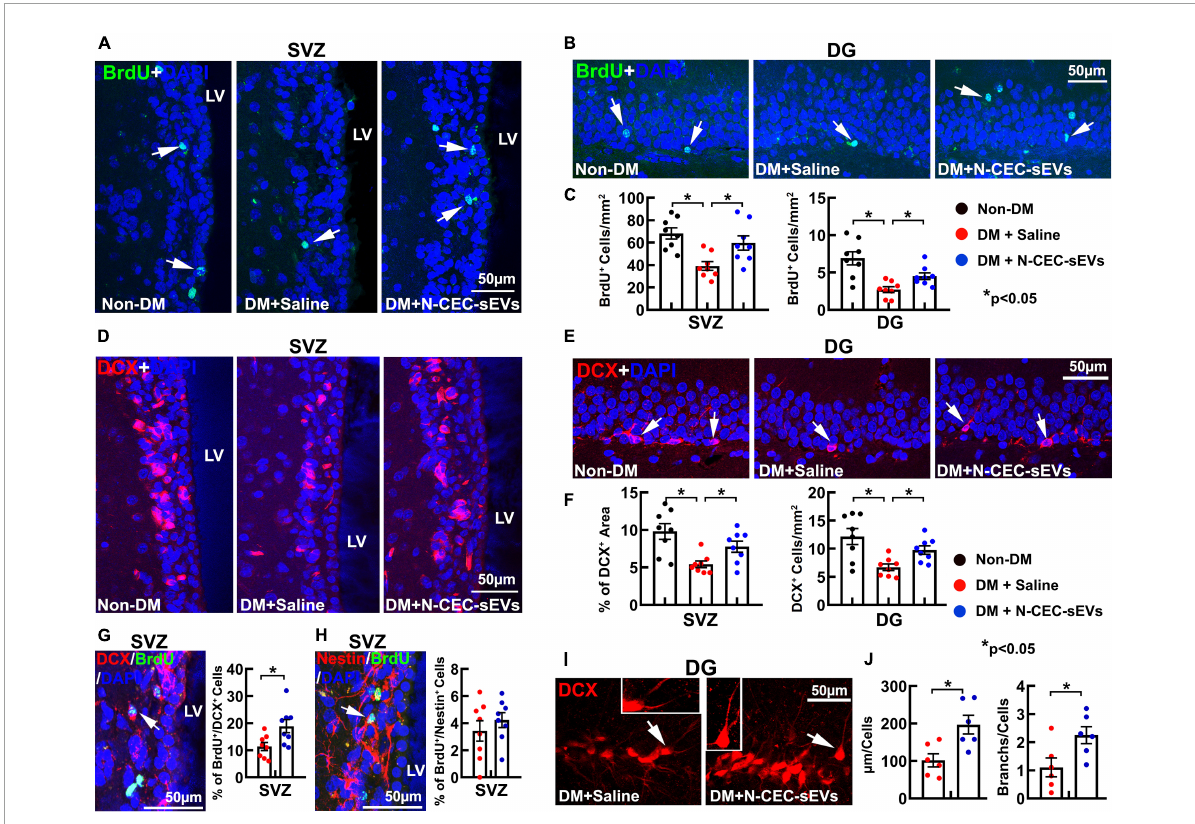
FIGURE3 N-CEC-sEV treatment promotes neurogenesis. Representative microscopic images (A,B) and quantitative data (C) of the BrdU positive cells (green, arrow) in the SVZ (A) and the DG (B) of age-matched non-DM rats and aged-DM rats treated with saline and N-CEC-sEVs. Representative microscopic images (D,E) and quantitative data (F) show DCX + neuroblasts (red) in the SVZ (D) and the DG (E) . Representative microscopic images of BrdU + cells double labeled with DCX ( G , arrow) and Nestin cells ( H , arrow) in the SVZ of aged-DM rats treated with N-CEC-sEVs. Bar graphs in (G,H) are the quantitative data of BrdU + /DCX + and BrdU + /Nestin + double labeled cells in the SVZ of aged-DM treated with saline and N-CEC-sEVs. Representative confocal microscopic images of DCX + neuroblasts (red) in the DG (I) of aged-DM rats. Inserts in I show a DCX + neuroblast (arrow in Saline) with short processes, whereas a DCX + neuroblast (arrow in N-CEC-sEVs) with long and branched processes. Bar graphs in (J) show N-CEC-sEVs increased branch number and length of DCX + neuroblast. LV: lateral ventricle. * p < 0.05 versus indicated